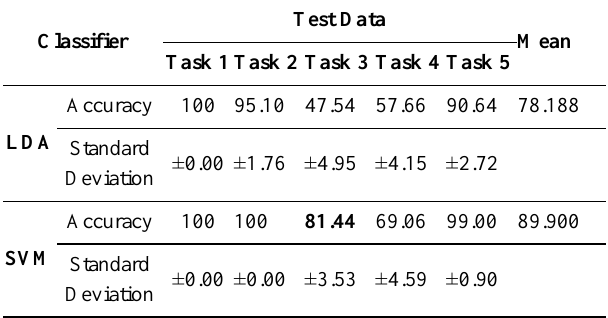
Table 3. Multi-class classification results of Subject 1 for 4